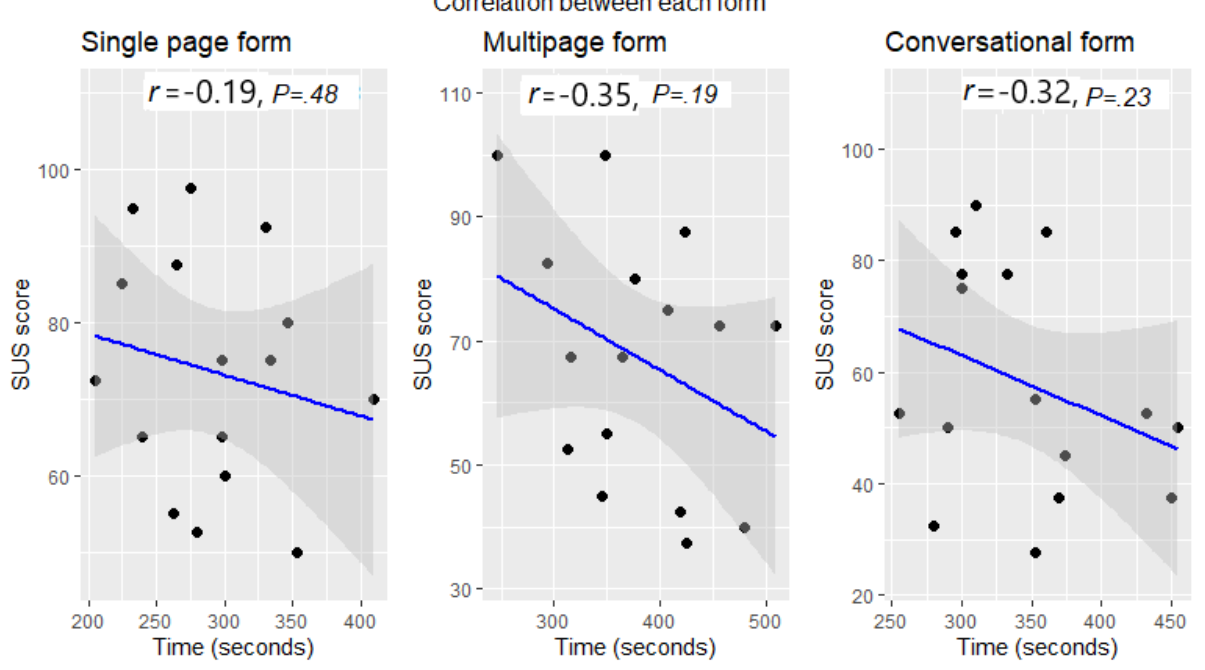
Figure 12. Scatterplot for the overall correlation between the System Usability Scale score and each form's completion time. SUS: System Usability Scale.